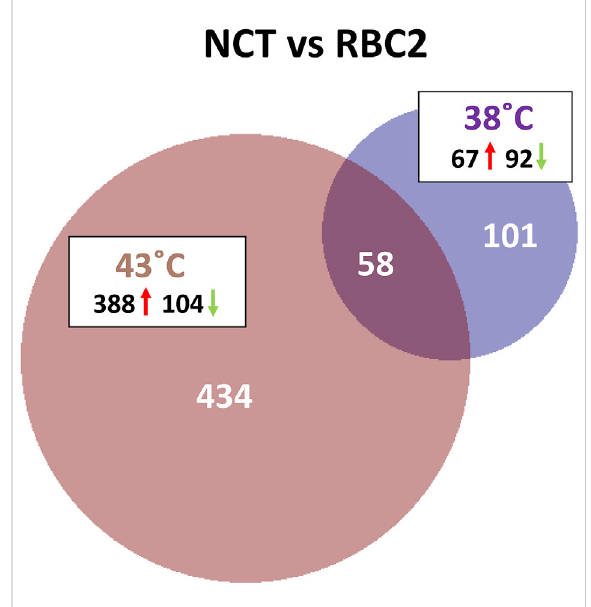
FIGURE 4 Distribution of differentially expressed genes between lines (F-line versus RBC2) during proliferation of p. major satellite cells. For each temperature comparison, the number of genes with FDR pval < 0.05 and |Log 2 FC| > 2.0 that were shared or unique to each incubation temperature are indicated. The number and direction of expression change ( ↑ or ↓ ) for the genes included in each temperature group are listed outside the Venn diagram. Circle size is proportional to the number of